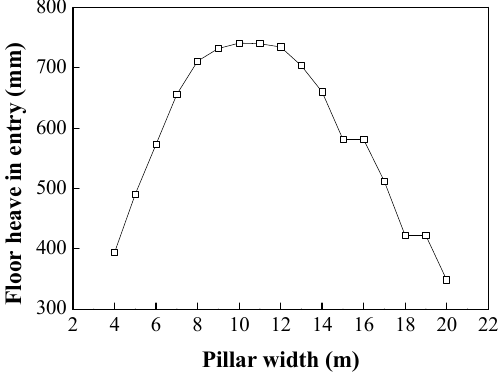
Figure 5. The relationship between the floor heave and pillar width in the gob-side roadway.